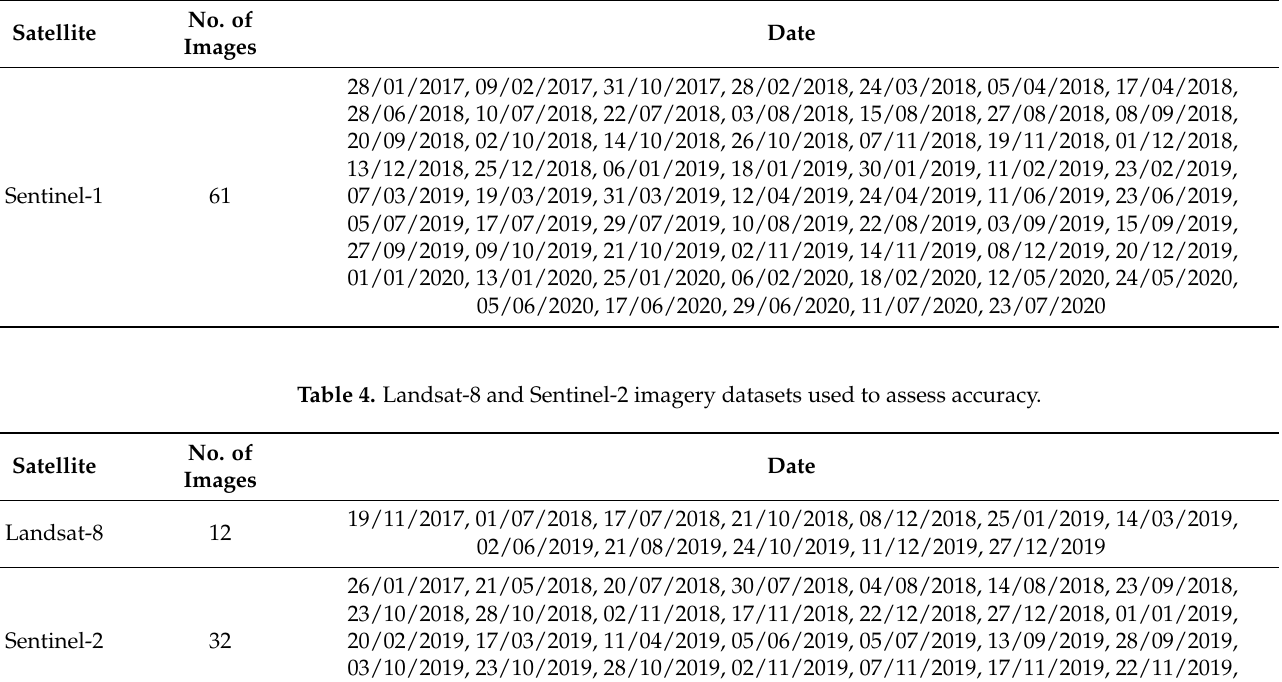
Table 3. Sentinel-1 imagery dataset used to assess accuracy.